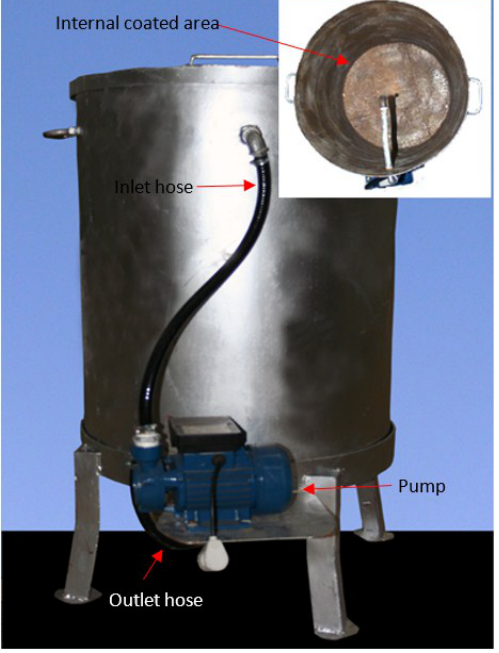
Figure 3. The 400-L water tank constructed from AISI 1020 steel (as used for the coating